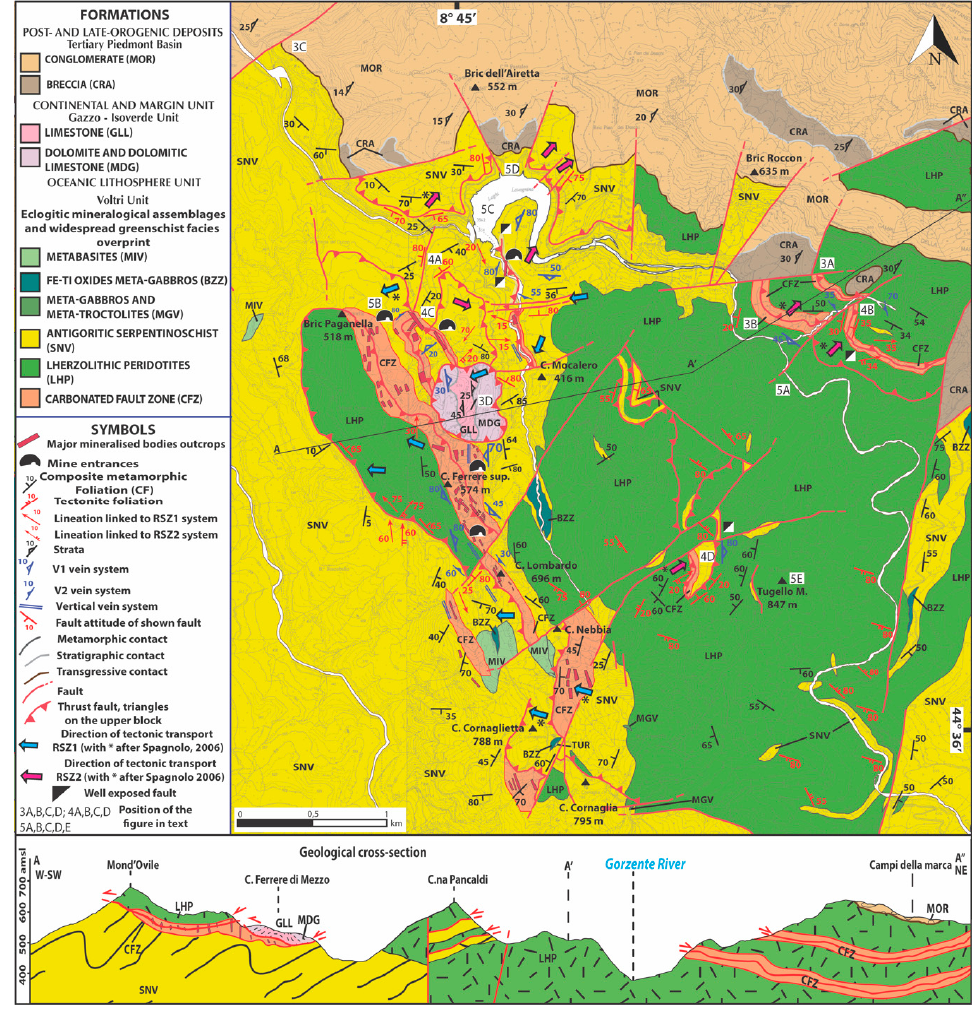
Figure 2. (Color online): Geological map of the Lavagnina Lakes area and relative geological cross-section.